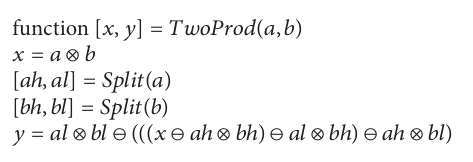
Algorithm 3: Product of two floating point numbers.